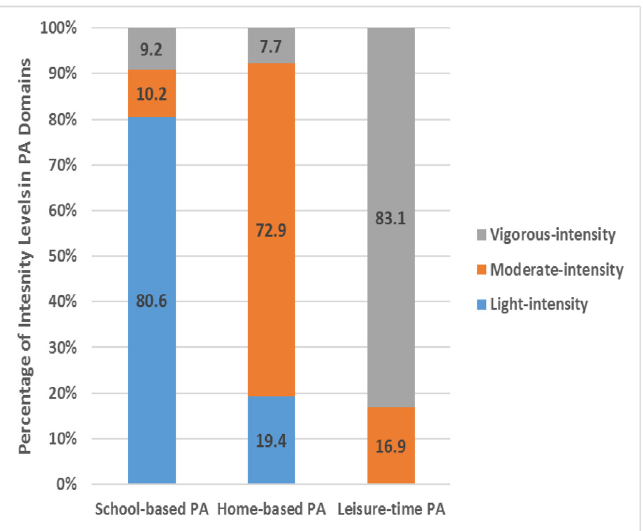
Fig 2. Proportion of intensity levels of activity reported in each domain of physical